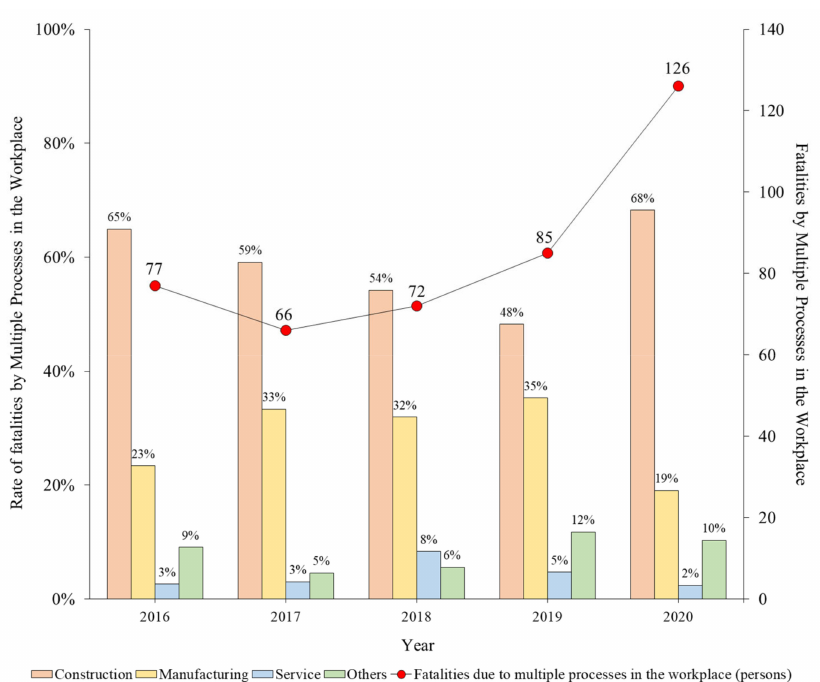
Figure 5. Percentage of fatalities caused by multiple processes in the workplace based on industry